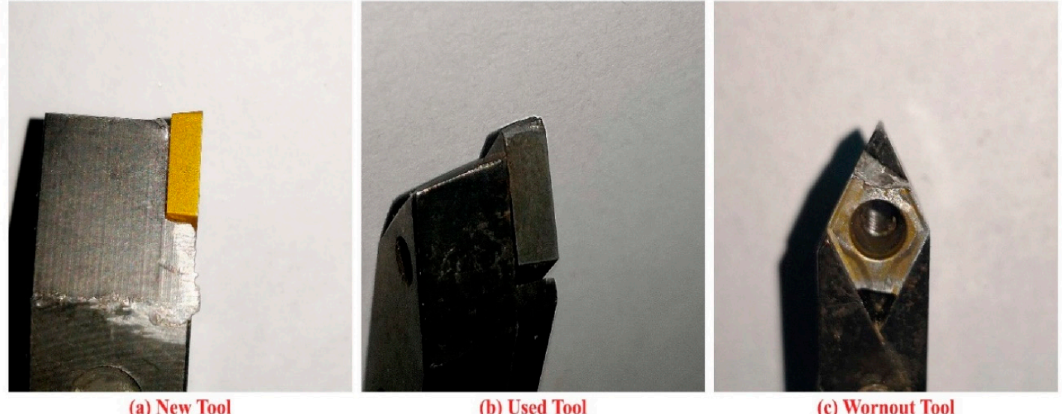
Figure 9. All three categories of carbide tool are shown where the level of tool degradation can be observed on each